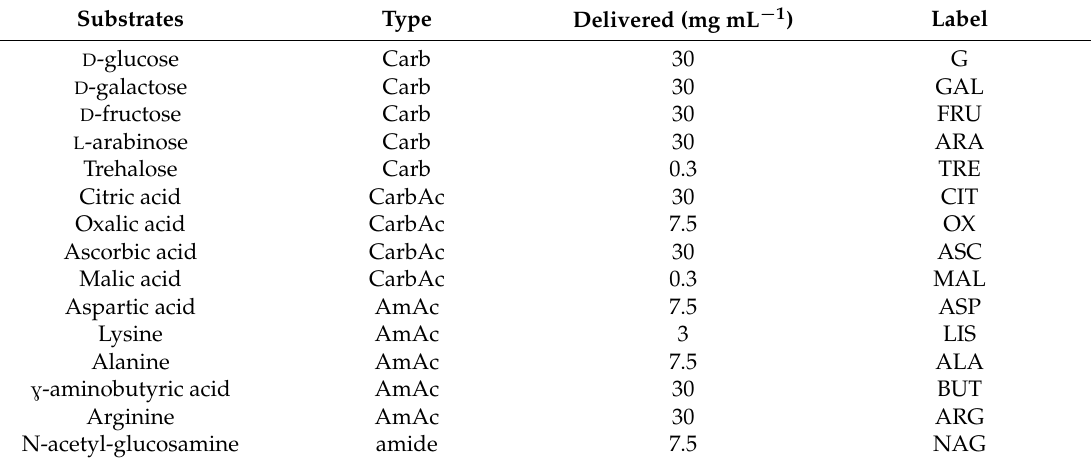
Table A2. Substrates used for CLPP analysis. Different amounts of delivered C depend on substrates’ solubility in water.